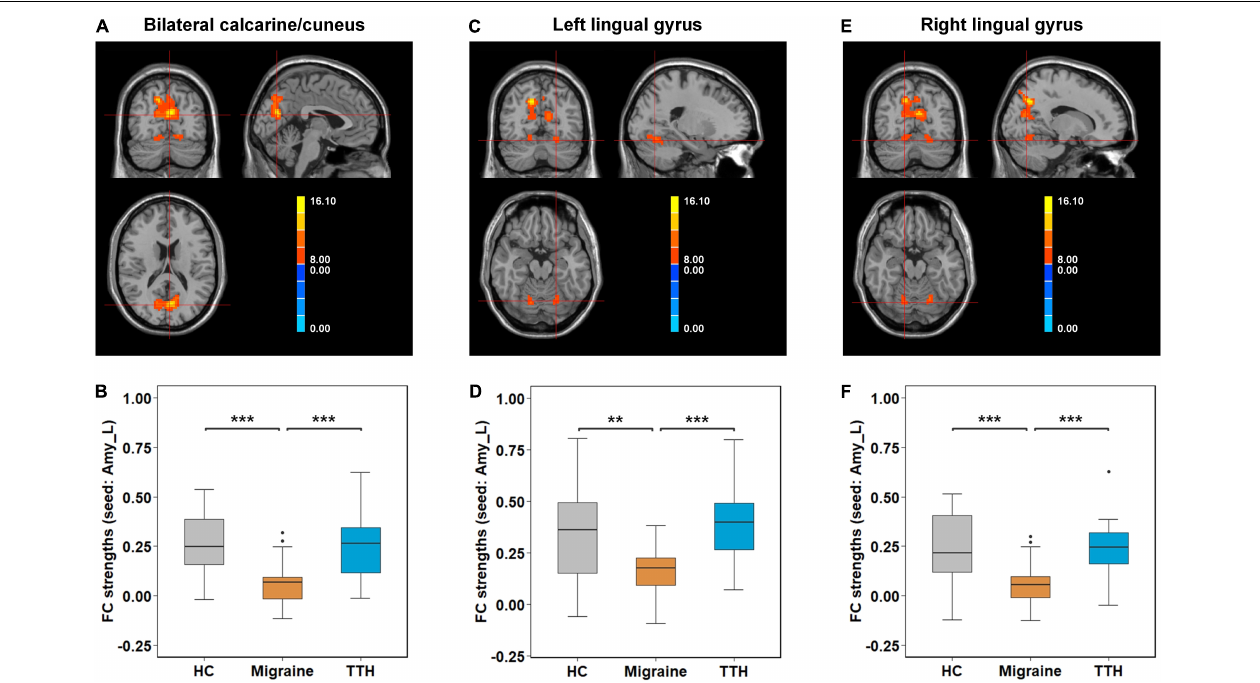
FIGURE 2 | Intergroup differences in rsFC strengths (seed: left amygdala). Migraineurs showed decreased rsFC of left amygdala with bilateral calcarine/cuneus (–3,–72, 18) (A,B) , left lingual gyrus (–21,–66,–18) (C,D) , and right lingual gyrus (15,–69,–18) (E,F) in comparison with HCs and patients with TTH. The pair-wise differences in the significant clusters observed in one-way ANCOVA ( Table 2 ) were tested using post-hoc t -tests. * p -value < 0.05; ** p -value < 0.01; *** p -value < 0.001. rsFC, resting-state functional connectivity; Amy_L, left amygdala; HC, healthy control; TTH, tension-type headache; ANCOVA, analysis of